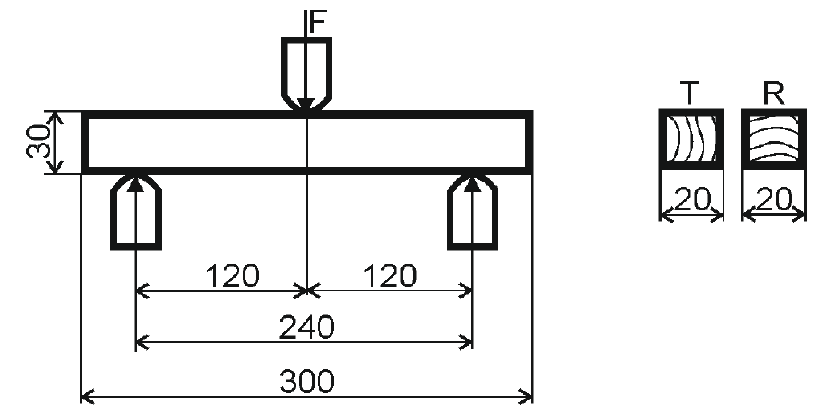
Figure 4. Test of wood in static bending.